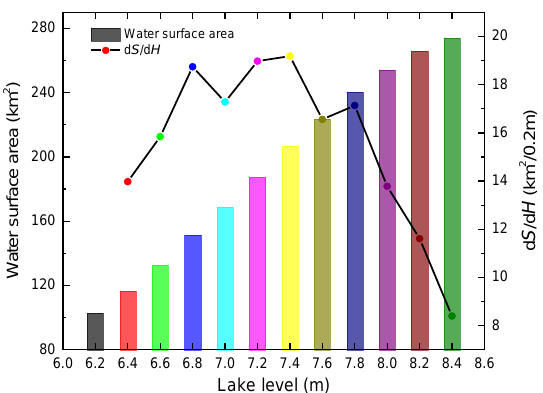
Figure 10. Response of water surface area and dS / dH to changes in lake level. dS / dH represents the rate of increased water surface area as a function of lake level.